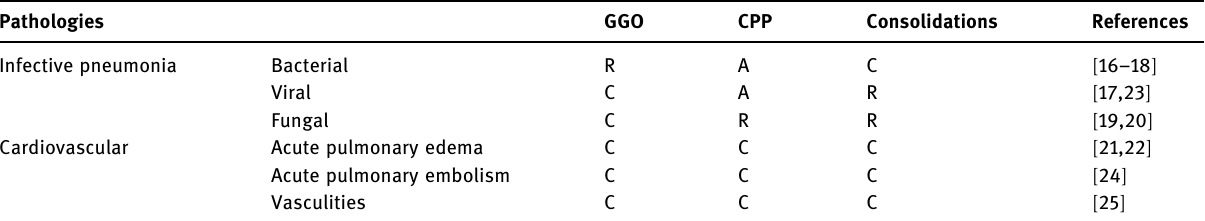
Table 2: Radiological features of pathologies in di ff erential diagnosis with COVID - 19 pneumonia